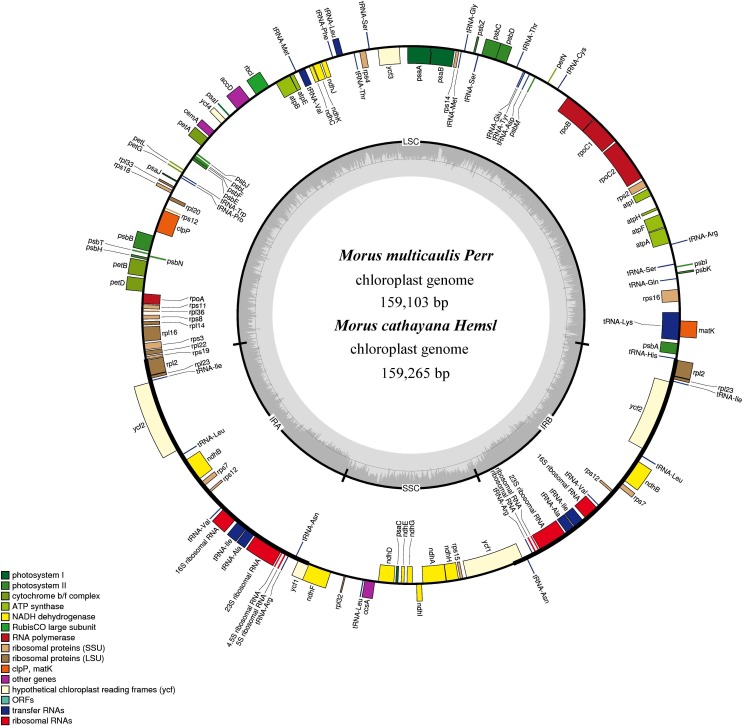
Gene map for M. cathayana and M. multicaulis plastomes.Genes lying outside the circle are transcribed in a clockwise direction, whereas genes inside are transcribed in a counterclockwise direction. Different colors denote known functional groups. The GC and AT contents of the genome are denoted by dashed darker and lighter gray in the inner circle. LSC, SSC, and IR indicate large single-copy, small single-copy, and inverted repeat regions, respectively.